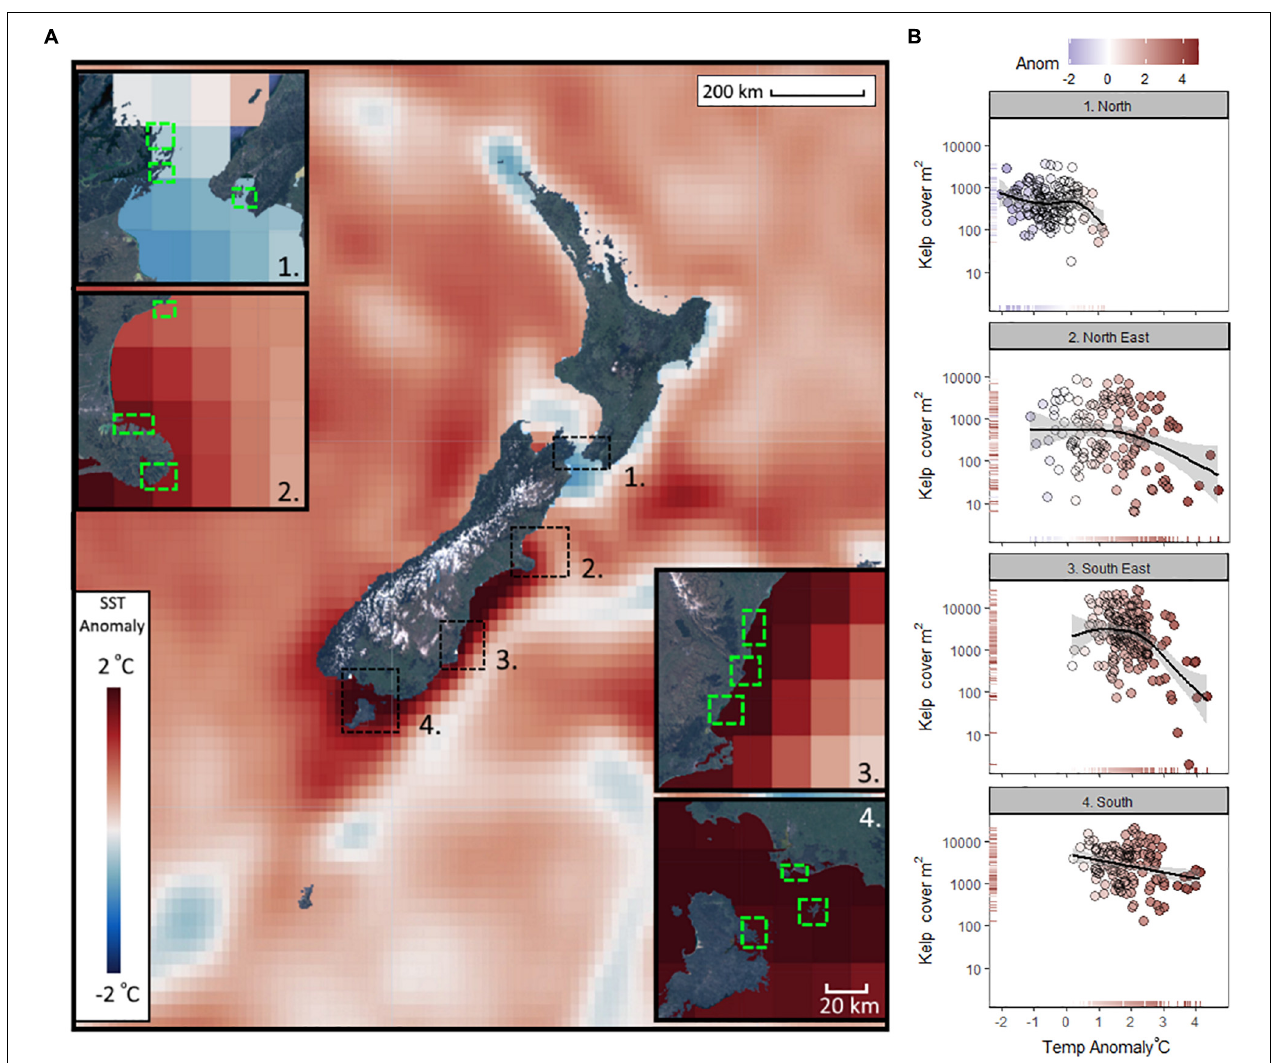
FIGURE 1 | Mean sea surface temperature (SST) anomalies observed across the southern Pacific Ocean surrounding New Zealand between 2015 and 2020, and within the coastal regions (1–4) where Macrocystis pyrifera was sampled remotely (A) ; and the relationship between temperature anomalies and kelp coverage for each month between Dec 2015 and Dec 2020 for each region (B) . Kelp cover (y-axis log transformed) plotted against anomaly is fitted with generalized additive models [formula y ∼ s(x, k = 5)] including standard error (B) . Temperature anomalies are calculated from the 38 year time series of SST (NOAA OISST